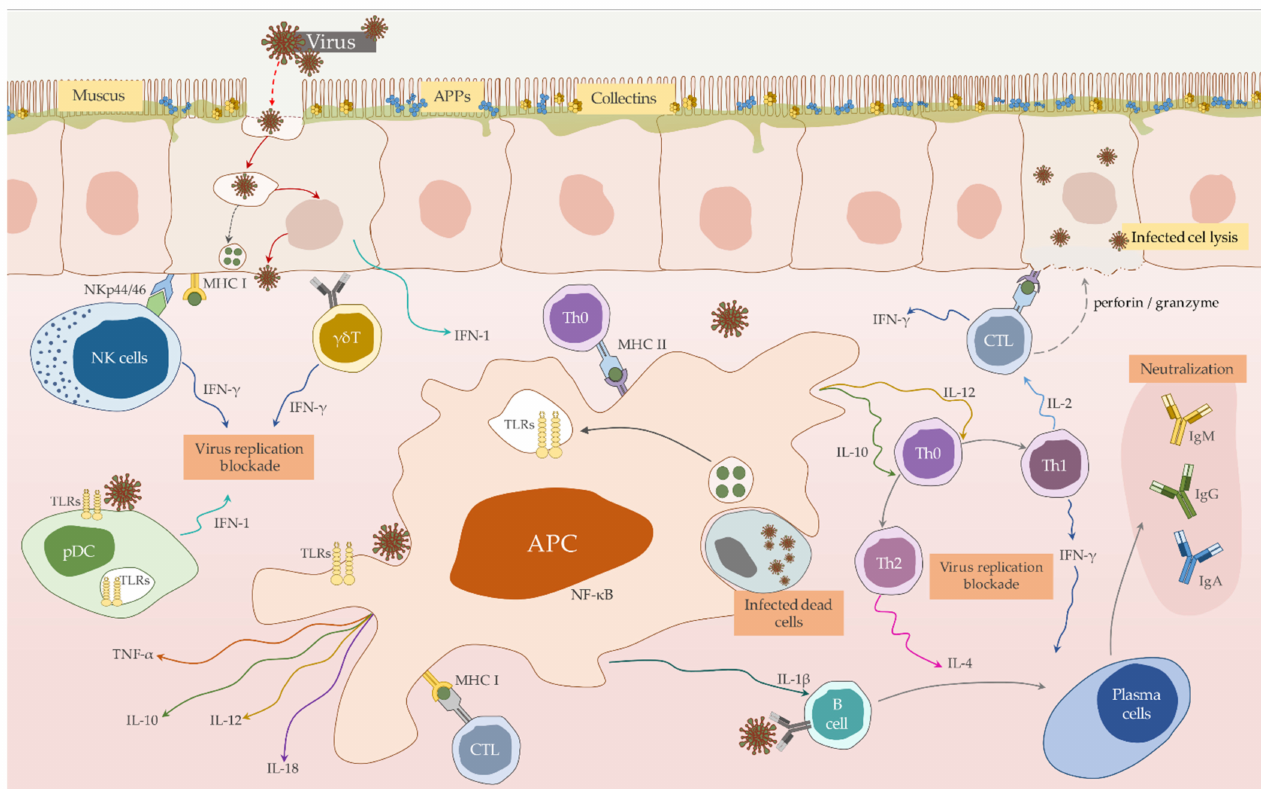
Figure 1. Schematic representation the mutual interaction of immune cells proven or assumed to be involved in the immune response against Lagovirus europaeus